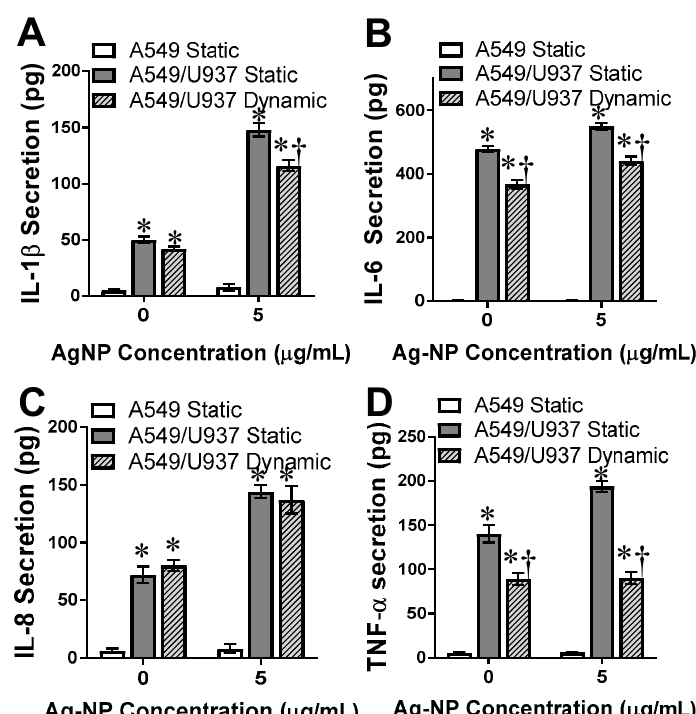
Figure 6. Secretion of pro-inflammatory cytokines as a marker of intracellular stress. The in vitro systems underwent a 24 h exposure, either untreated or following introduction of 5 µg/mL AgNPs, after which the media was evaluated for secreted levels of the pro-inflammatory cytokines of ( A ) IL-1 β , ( B ), IL-6, ( C ) IL-8, and ( D ) TNF- α . * and † denote statistical significance from static, untreated A549 cells and between A549/U937 static and dynamic at the same AgNP concentration, respectively, n = 3, p < 0.05.